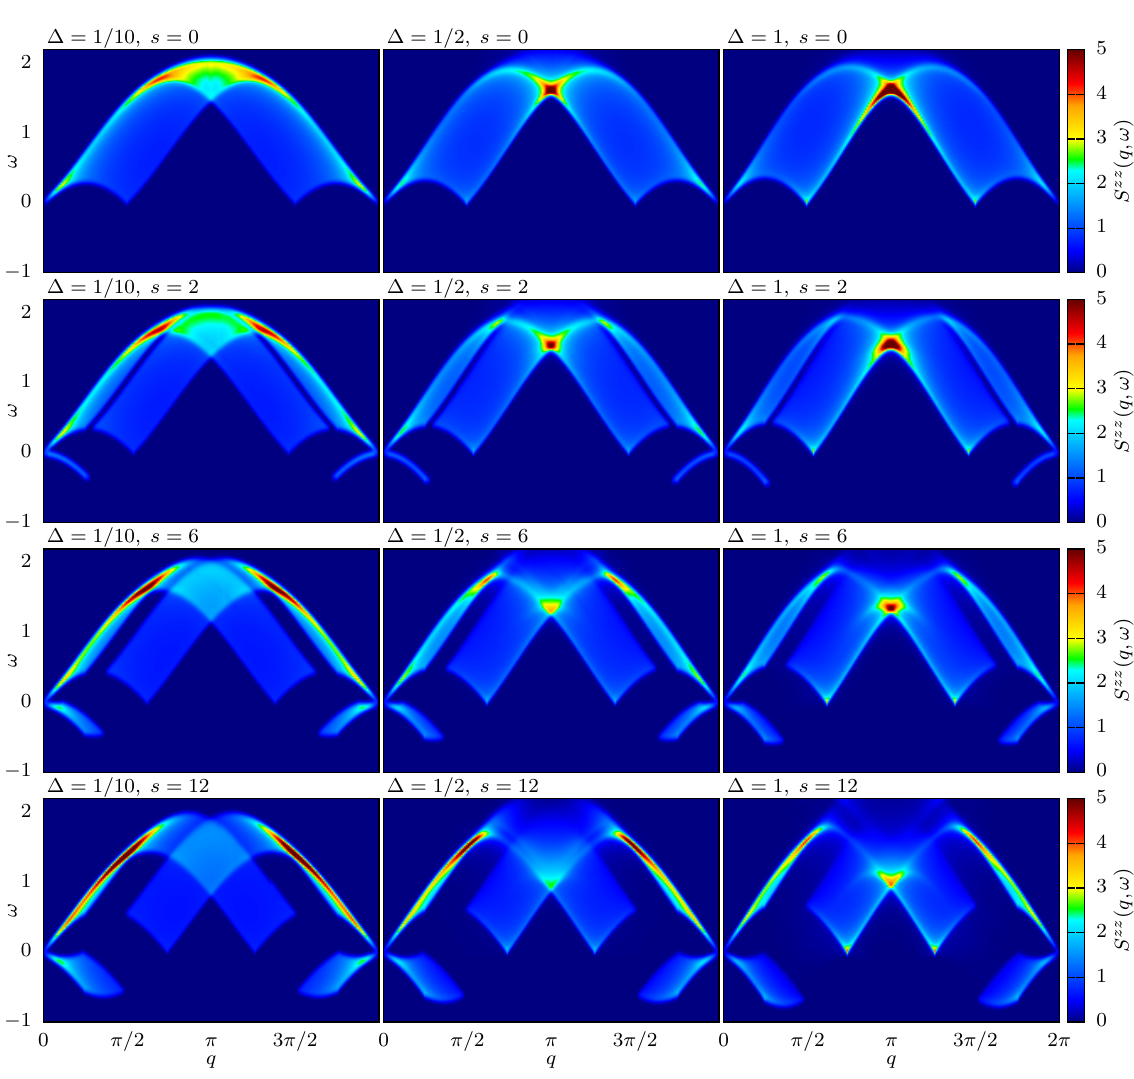
Figure 2: Longitudinal dynamical structure factor S zz ( q , ω ) at N = 200, M = 50 computed from summations of matrix elements obtained from algebraic Bethe Ansatz. From left to right, the anisotropies are ∆ = 1 , 1 ,1. From top to bottom, the momentum shifts in the quantum 10 2 numbers are s = 0,2,6,12. The corresponding sum rule saturations of the data are listed in Tab.